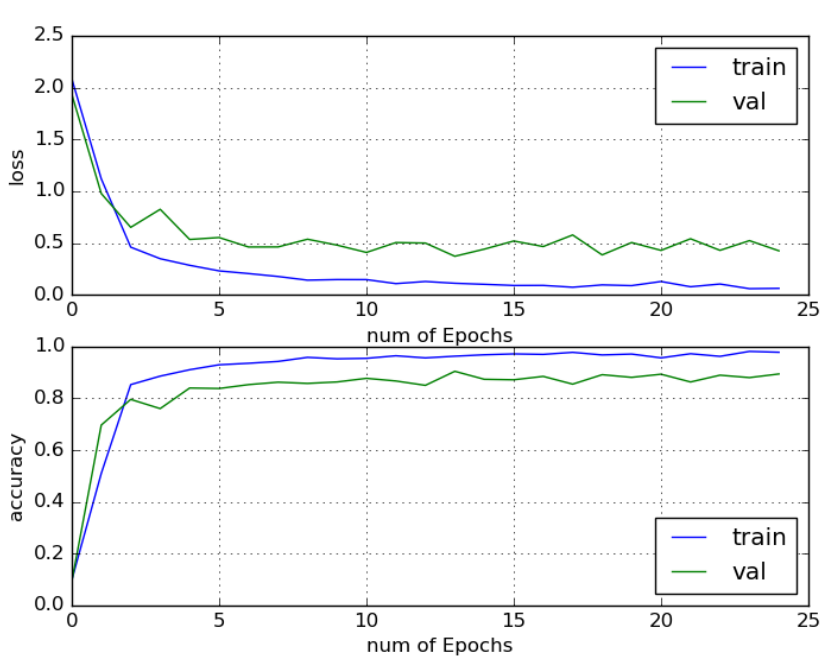
Figure 6. VGG-16 fine tune model on CVSI-15 using Adam optimizer.